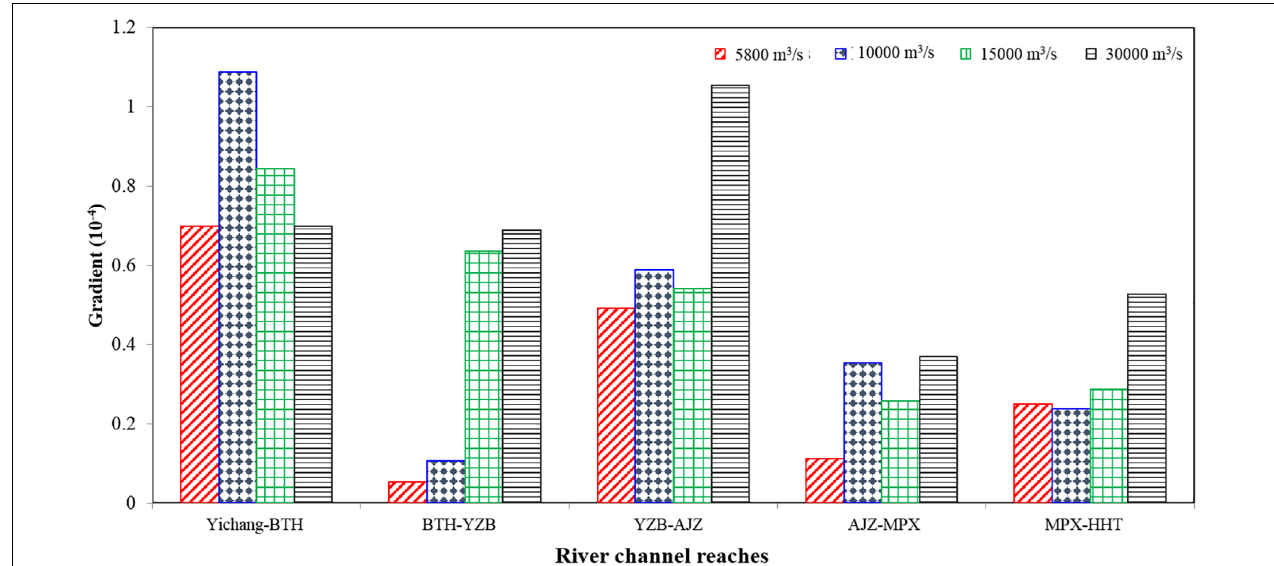
FIGURE 7 | Water surface gradient of each section of the Yichang reach at different flow discharges in 2012.